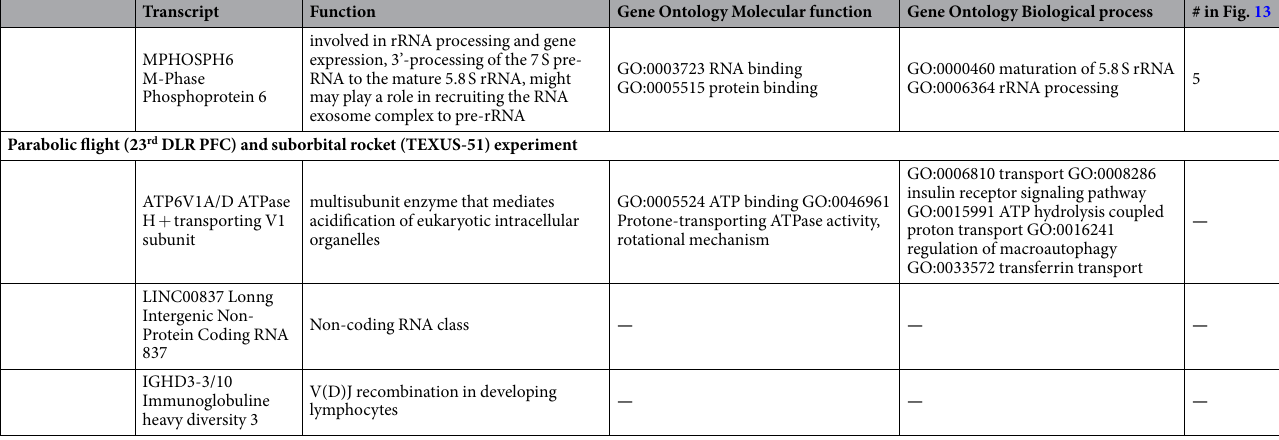
Table 9. Gravity-responsive transcripts. Transcripts from parabolic flight (23 rd DLR parabolic flight campaign) and suborbital rocket experiments (TEXUS-51) that are differentially expressed in both, microgravity and hypergravity. Transcript names, annotated functions and gene ontology entries were adopted from the GeneCards encyclopedia (www.genecards.org). The numbers allocate the genes to the cellular processes and pathway components in Fig.